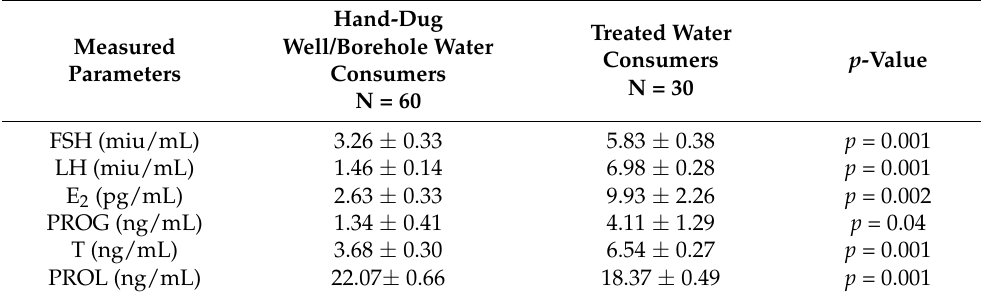
Table 5. Comparison of serum sex Hormone levels among Hand-dug Well/Borehole Water Con- sumers and Treated water